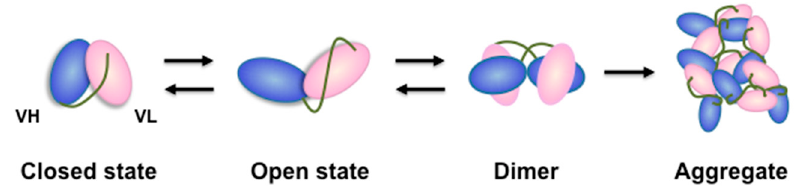
Figure 1. Schematic model of the aggregation process of scFv.